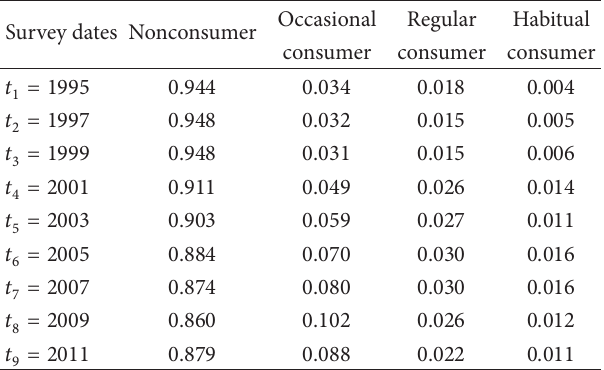
Table 1: Survey results. % of people who belong to nonconsumers, occasional consumers, regular consumers, or habitual consumers of cocaine in Spain from 1995 to